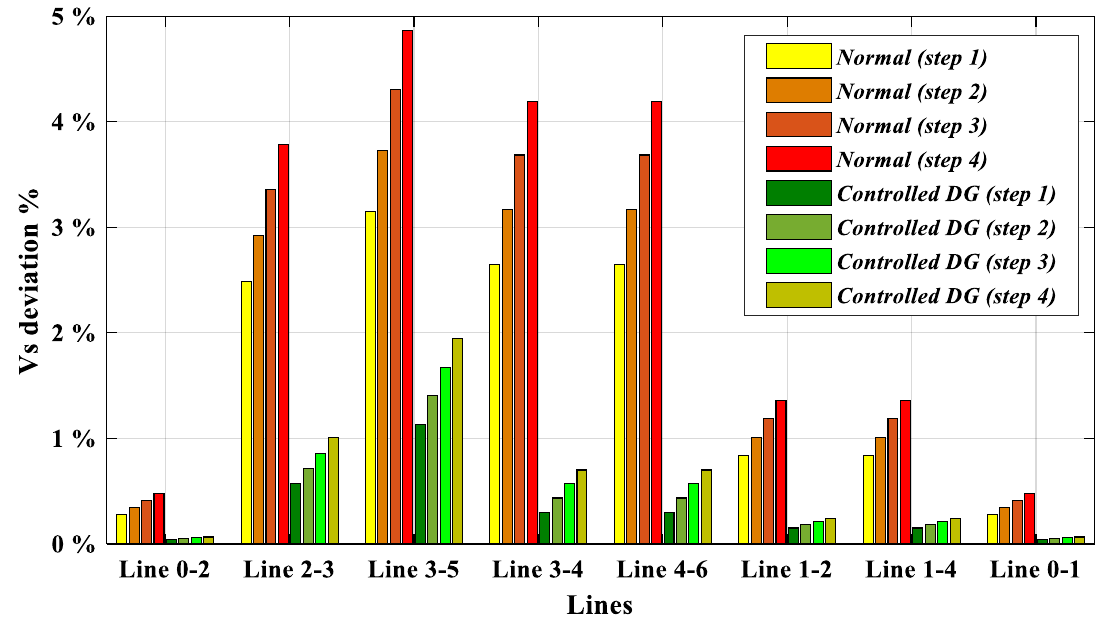
Figure 7. Sending voltage deviation % for all transmission lines.